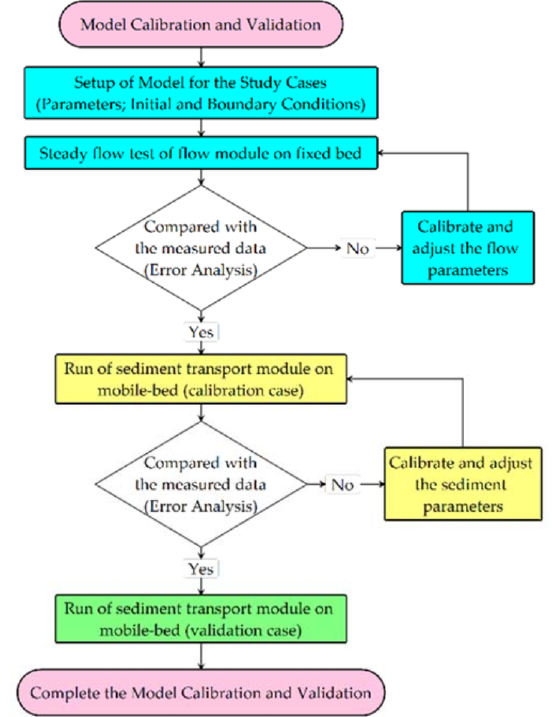
Figure 9. Flowchart of model calibration and validation using the original model.